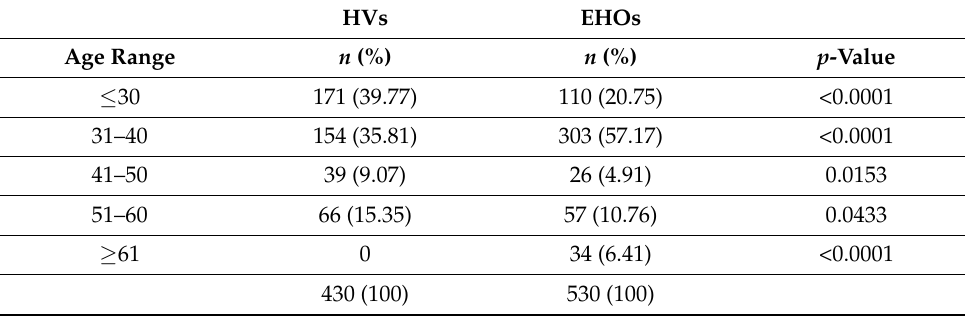
Table 2. Number of respondents by age group.